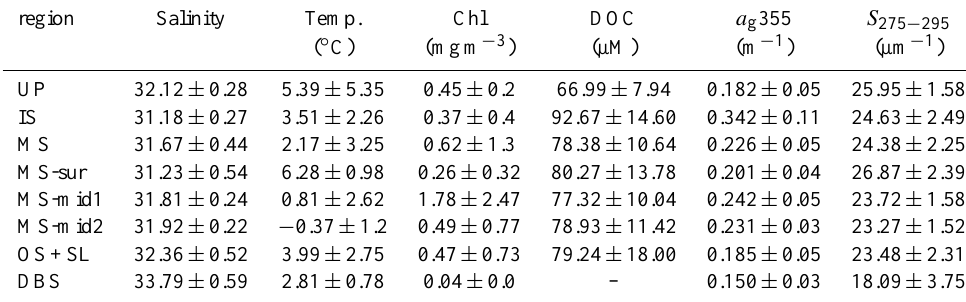
Table 1. Mean salinity, temperature, Chl fluorescence, DOC concentrations, CDOM absorption at 355nm ( a g 355), and spectral slope S or S 275 − 295 measured in different regions (IS-inner shelf, MS-middle shelf, OS-outer shelf, SL-slope, and UP-Unimak Pass) of the Bering Sea. In the MS region, mean values of the properties at the surface, mid-1 and mid-2 depths are also given. Mean values of the properties in the deep Bering Sea (DBS) with salinity in the range 33–35 are shown. region Salinity Temp. Chl